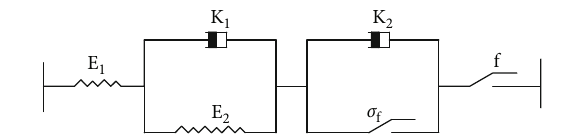
Figure 2: Comprehensive model diagram of rheological